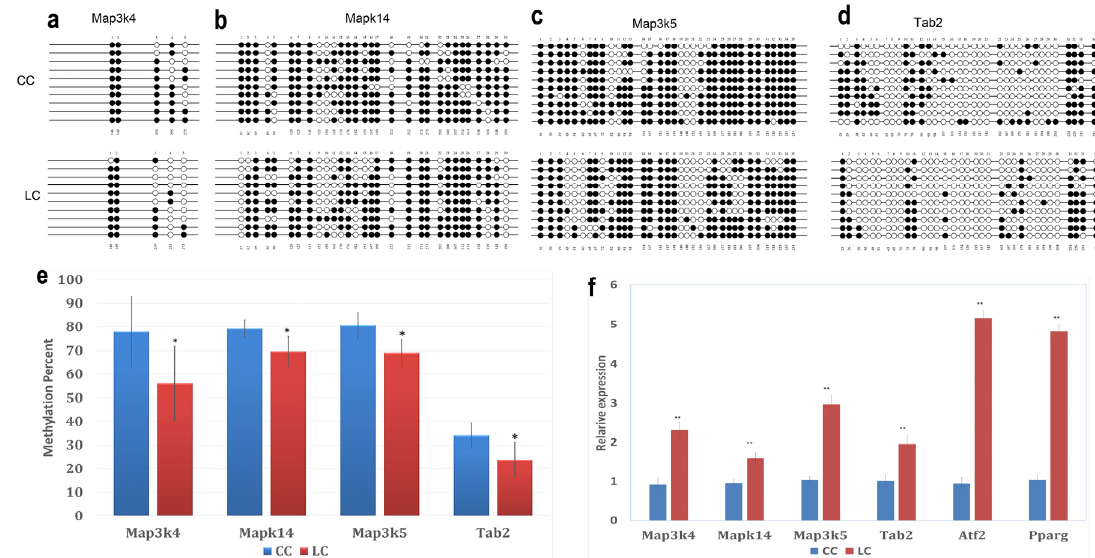
Figure 6. Effects of maternal low chromium diet on methylation of Map3k4 ( a ); Mapk14 ( b ); Map3k5 ( c ); and Tab2 ( d ) and relative expression ( f ) of genes in adipose of offspring. For bisulfite sequencing (BSP) results, white circles represent unmethylated CpGs, and black circles represent methylated CpGs ( a – d ); figure e shows the analysis of DNA methylation status. Values are expressed as means ± SD, n = 8 per group. For BSP, pooled DNA of eight mice adipose for each group is what we used for analysis. For each gene in each group, 10 clones randomly selected were analyzed and represent the average methylation level for the indicated genes. * p < 0.05, ** p < 0.01, vs. CC. Map3k4 : mitogen ‐ activated protein kinase kinase kinase 4; Mapk14 : mitogen ‐ activated protein kinase 14; Map3k5 : mitogen ‐ activated protein kinase kinase kinase 5; Tab2 : TGF ‐β‐ activated kinase 1/MAP3K7 binding protein 2; Pparg : peroxisome proliferator activated receptor gammas; Atf2 : activating transcription factor